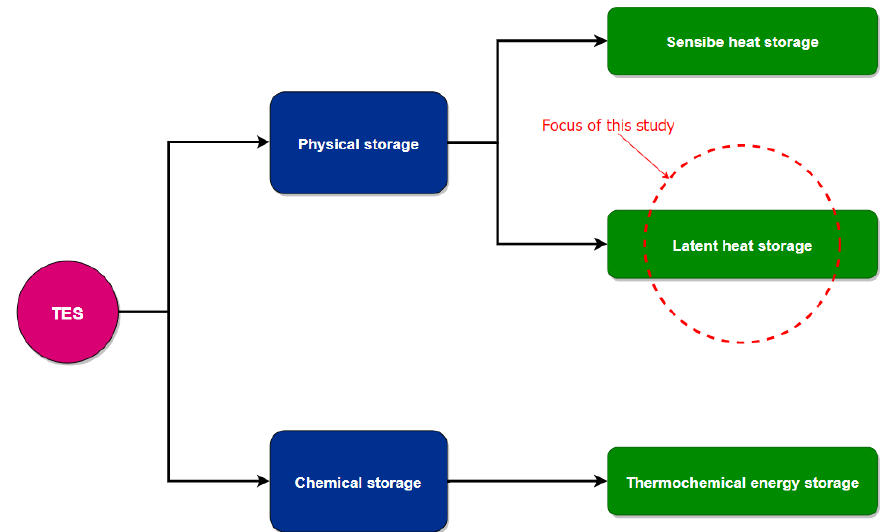
Figure 1. Classification of TESs. Adapted with permission from Ref. [3]. Copyright 2019 International Journal of Heat and Mass Transfer.